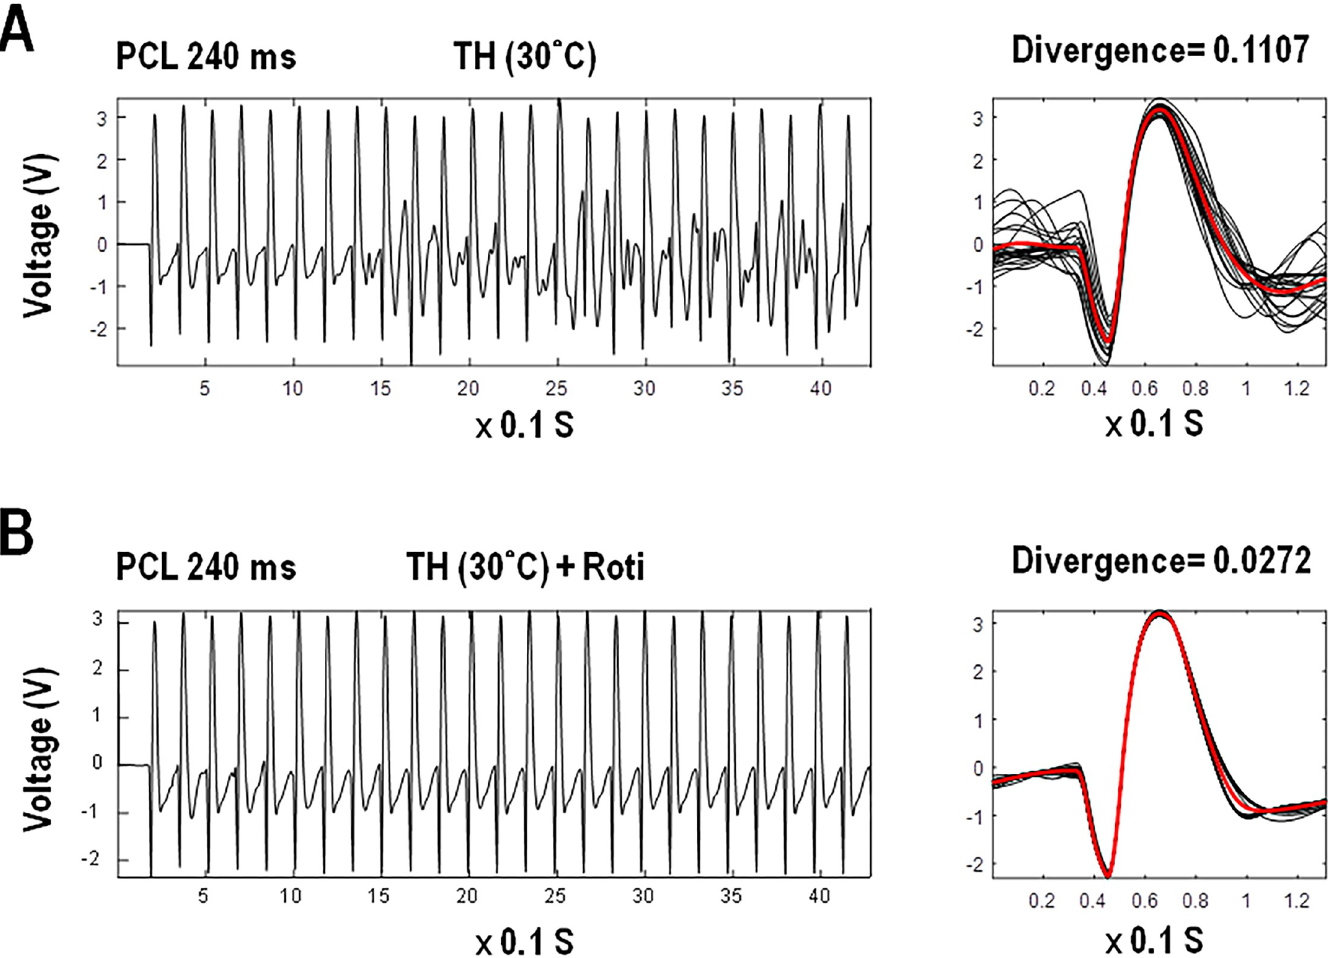
Fig 3. Two examples of divergence analysis at burst ventricular pacing cycle length (PCL) of 240 ms during therapeutic hypothermia (TH, 30˚C) in heart #10. A, without rotigaptide, this episode shows significant morphological variation during pacing with a high divergence of 0.1107. VF occurred immediately after stopping pacing. B, with rotigaptide, this episode shows minimal morphological change during pacing with a low divergence of 0.0272. Normal rhythm was observed immediately after stopping pacing.